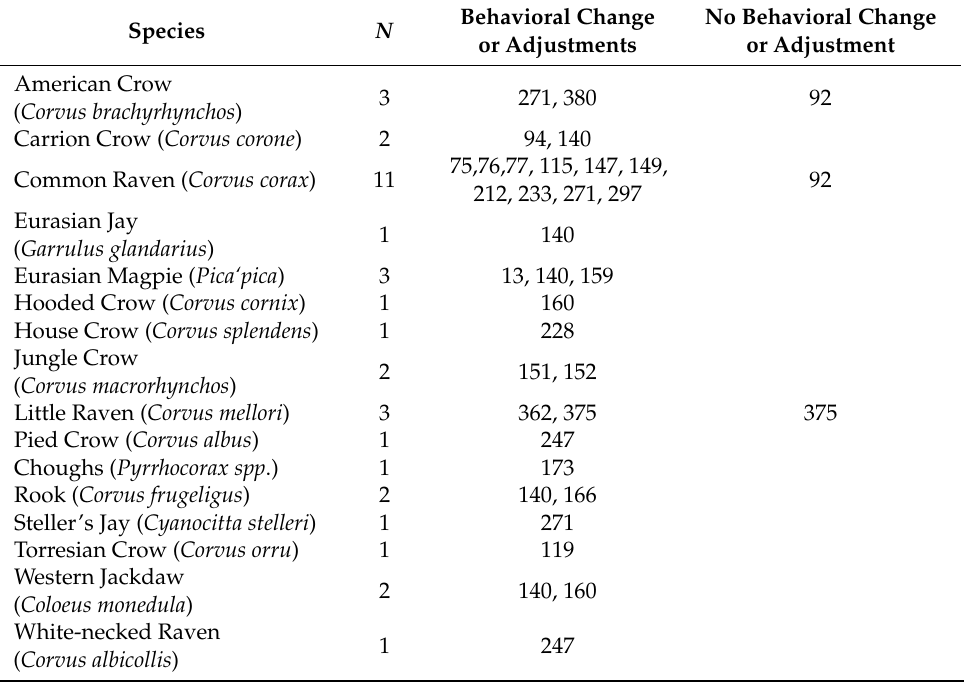
Table 9. List of articles reporting behavioral change or adjustment of corvid species in